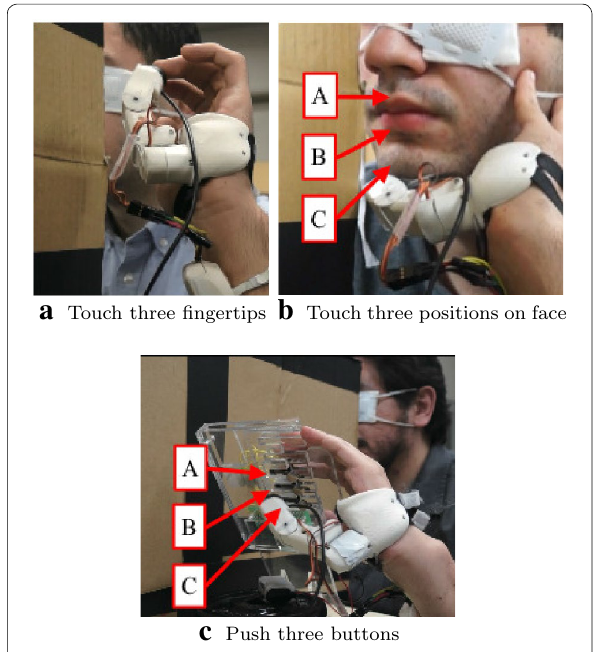
Fig. 7 Experiments under three conditions. Three conditions are performed by controlling ERT a to touch three fingertips, b to touch three positions on face, and c to push three buttons on a auditory feedback device. The locations of A, B, and C for condition 1 are: A for ring finger, B for middle finger, and C for index finger. The locations of A, B, and C for condition 2 and condition 3 are marked inside